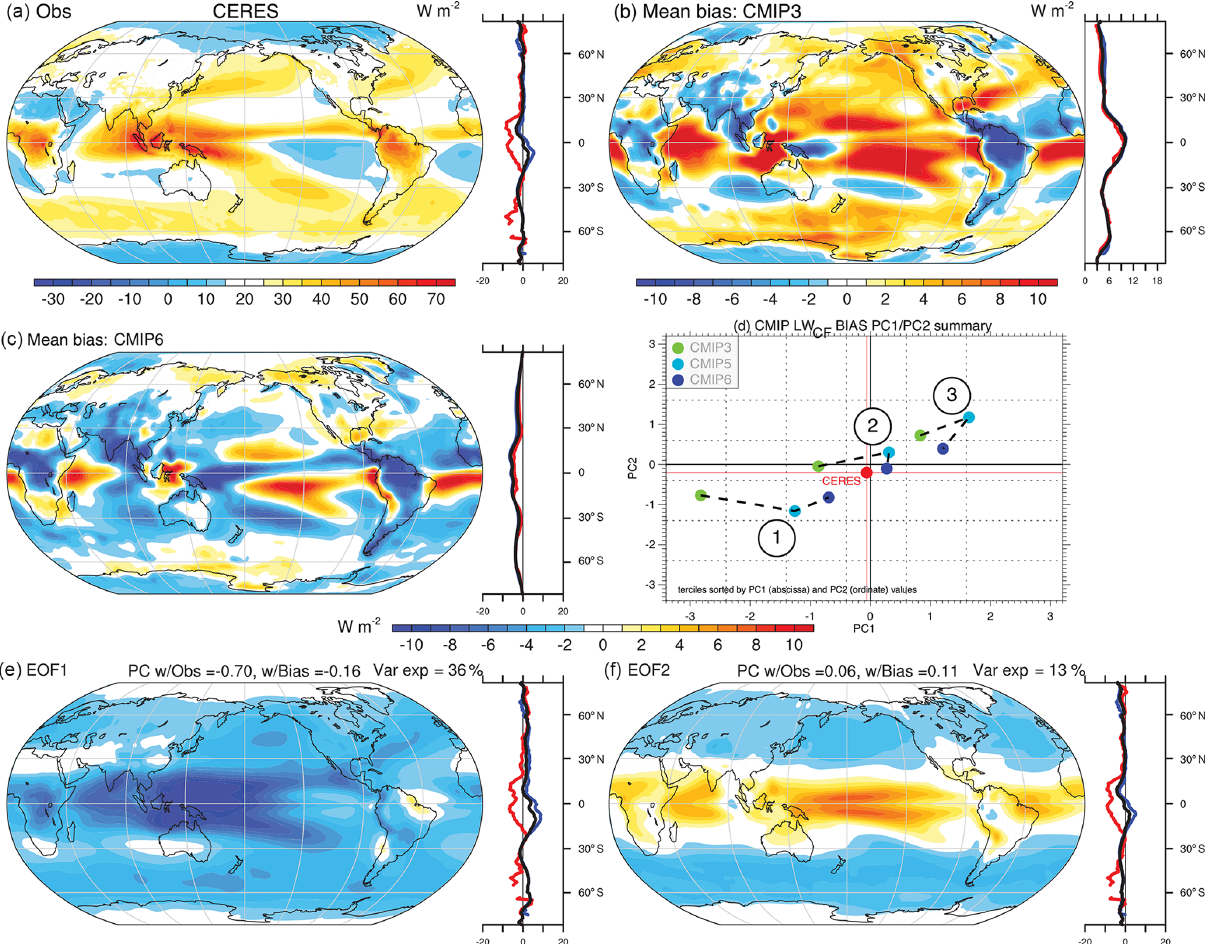
Figure 7. Analysis of the annual mean LW CF bias in the combined historical CMIP3/5/6 archive including the following: (a) the observed estimate from CERES EBAFv4.1; the mean biases in (b) CMIP3 and (c) CMIP6; and (d) the first two PCs of biases and their tercile averages across the CMIP archives and the associated (e) first and (f) second EOFs of biases. All units are watts per square meter (Wm − 2 ), except for the PCs, which are unitless. Zonal means (right panels) include land (red), ocean (blue), and global